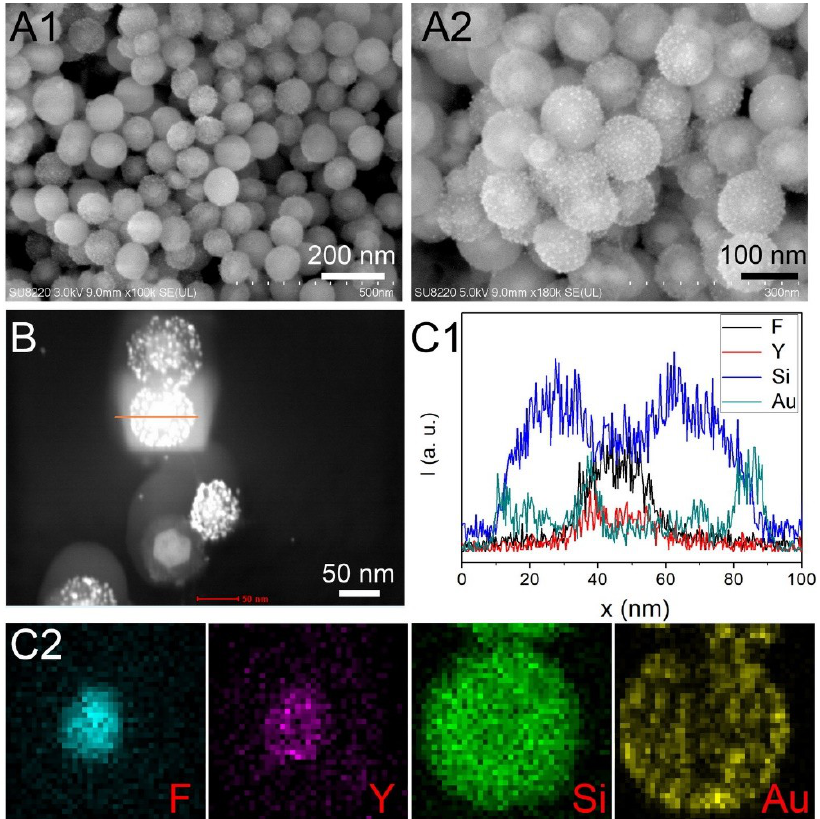
Figure 3. ( A1 , A2 ) SEM images at different magnifications, ( B ) High-angle annular dark-field scanning transmission electron microscopy (STEM) images, ( C1 ) line scanning intensity I (x) with x indicating the position, and ( C2 ) map scanning images of UCNP@mSiO 2 -Au NPs ( R 1 = 15 nm, D = 30 nm, Z = 2–4 nm).